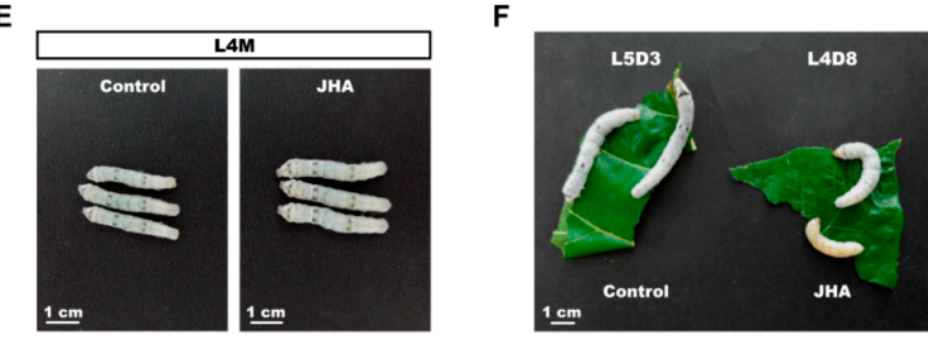
Figure 3. Change of larval growth and molting by JHA application at the beginning of the second instar. ( A ) The expression of Kr-h1 was increased at 6 h and 12 h after JHA treatment. The error bars represent the mean ± S.E. ( n = 3). The significance of the difference between data sets was calculated using two-tailed Student’s t -test. ** p < 0.01,